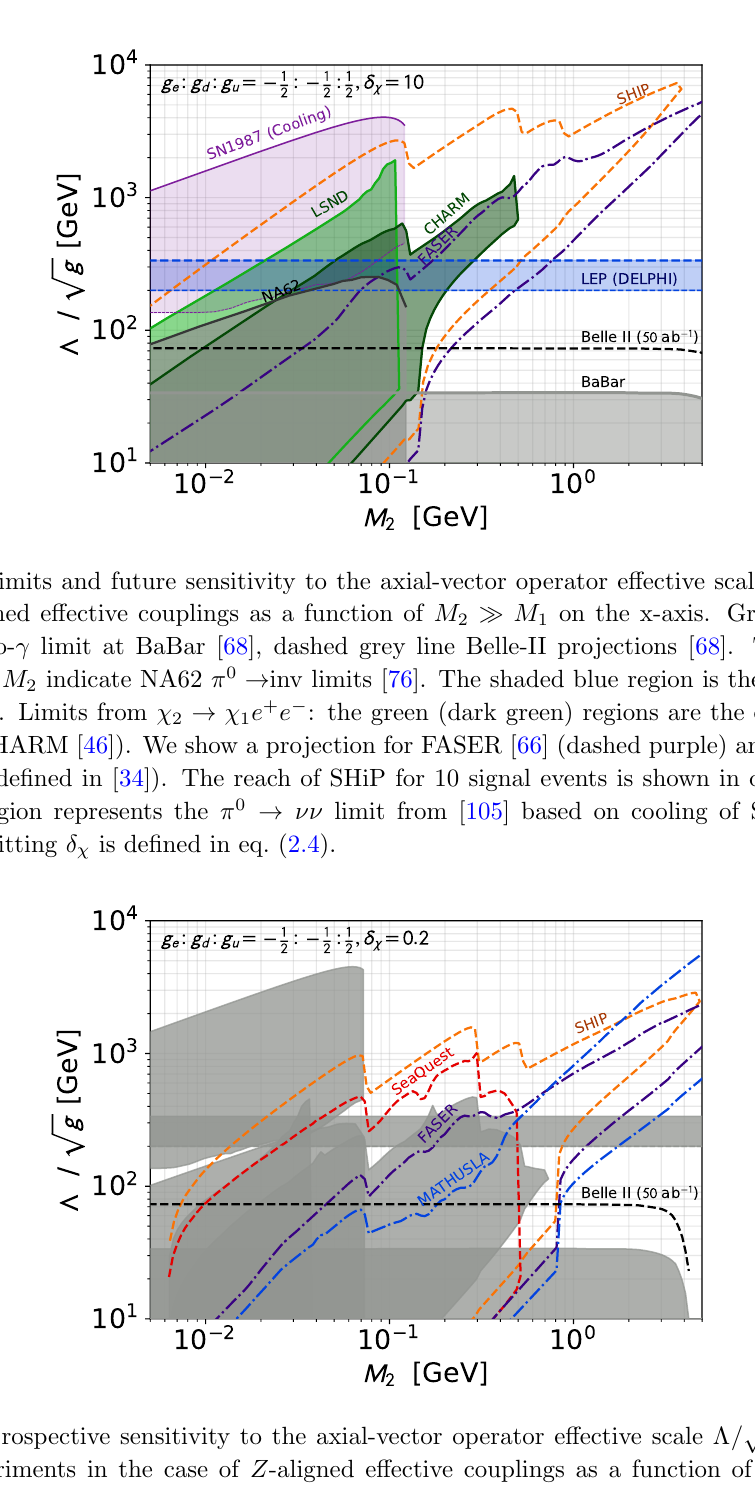
Figure 12 . Prospective sensitivity to the axial-vector operator e(cid:11)ective scale (cid:3) = intensity experiments in the case of Z -aligned e(cid:11)ective couplings as a function of M 2 on the x- axis for (cid:14) (cid:31) = 0 : 2. Grey areas indicate already covered parameter space. We show prospects for FASER [66] in dashed purple and SeaQuest in red (Phase-II de(cid:12)ned in [34]), MATHUSLA [66] in blue and SHiP in green (based on our 10 events projections). The normalised splitting (cid:14) (cid:31) is de(cid:12)ned in eq.